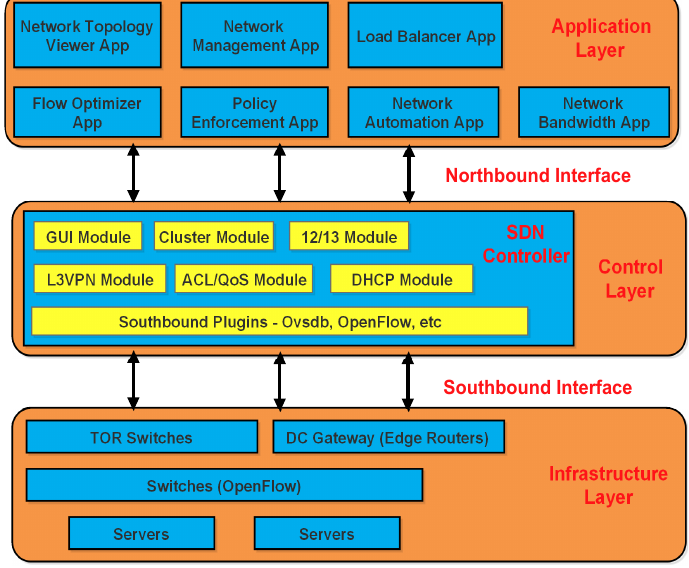
Figure 1. Architecture of Software-Defined Networking